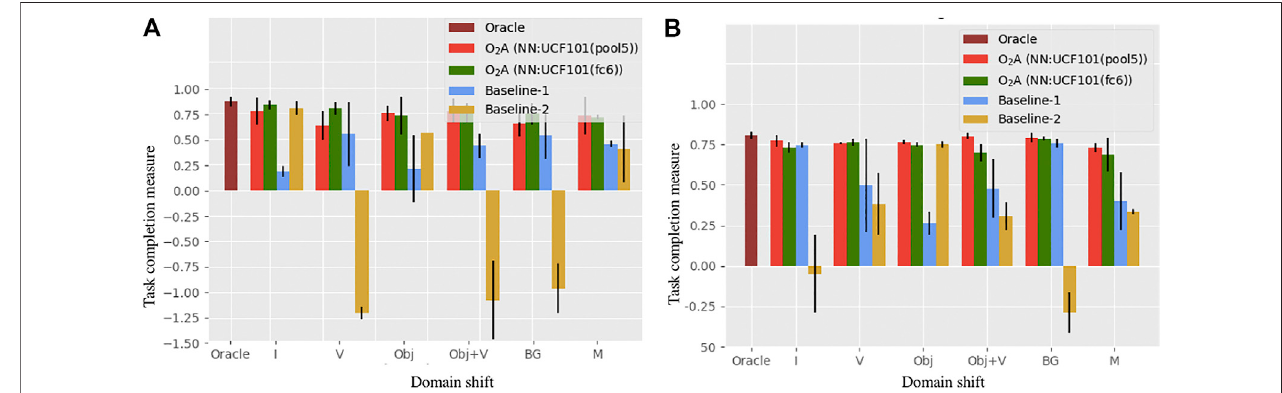
FIGURE 5 | Task completion measures for the task of (A) reaching and (B) pushing in the simulation experiment. O 2 A outperforms both the baselines and has performancecomparabletotheOracleunderalldomainshifts.TheOraclescoreisshownonlyoncesinceitisunaffectedbythedomainshifts(referto Table4 fordomain shift de fi nitions).